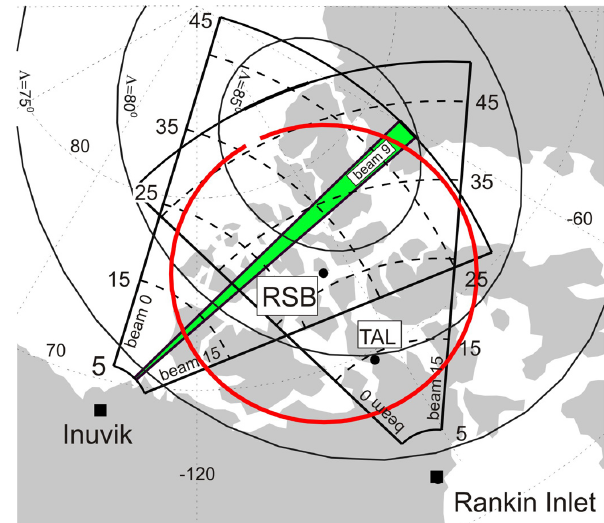
Fig. 1. Field of view (FoV) of the Rankin Inlet and Inuvik Po- larDARN radars between range gates 5 and 50. The dashed lines indicate radar ranges according to gate number (5....45). The green sector within the Inuvik radar FoV indicates the orientation of beam 9, the data from which will be discussed in more detail. The red solid circle represents the FoV of the Resolute Bay all-sky camera (for off-zenith angles of < 75 ◦ ) for the assumed 630-nm lu- minosity height of 250km. TAL is the location of another all-sky camera, data from which were considered but not presented in this